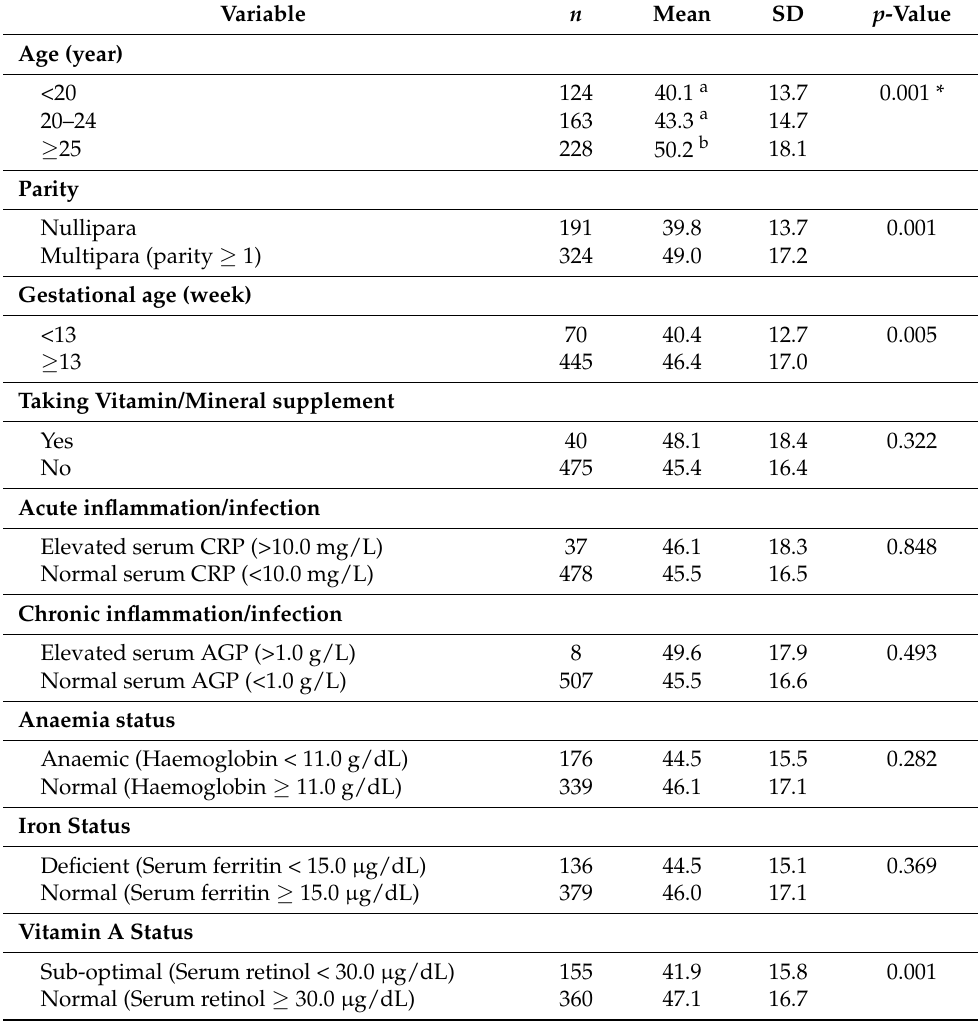
Table 2. Differences in mean vitamin D concentrations among pregnant rural women by age, parity and gestational age, inflammation/infection and selected micronutrient status group.